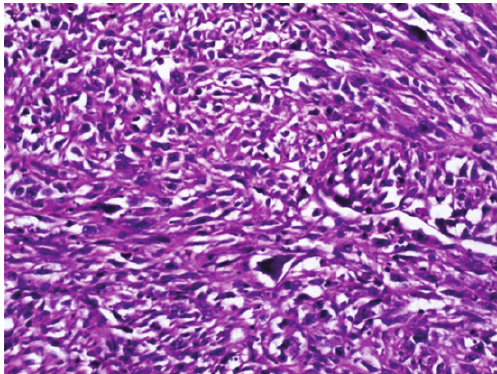
Figure 1: Cut section of specimen showing large grey-white tumor with central cystic area.